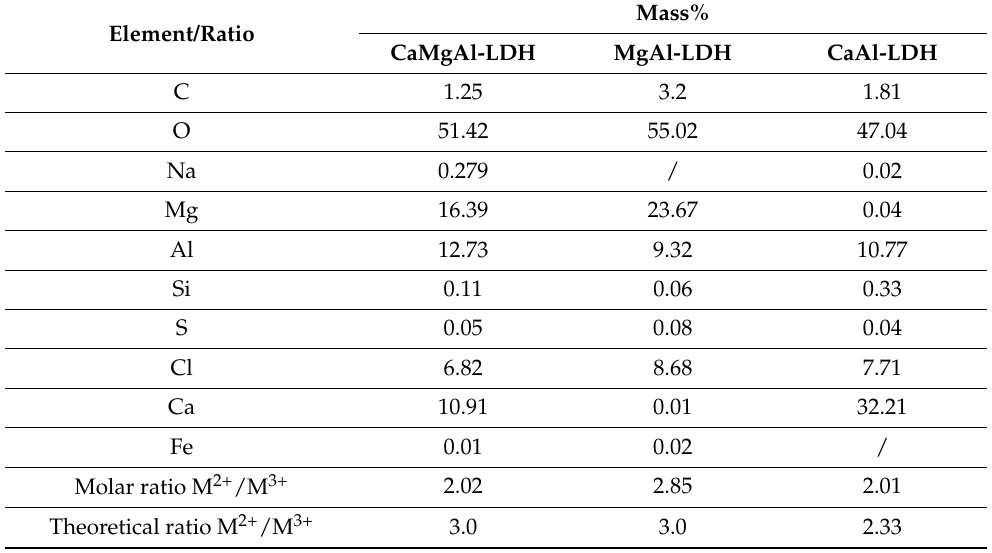
present in the materials as compensating anions. Table 4. XRF analysis of the materials.